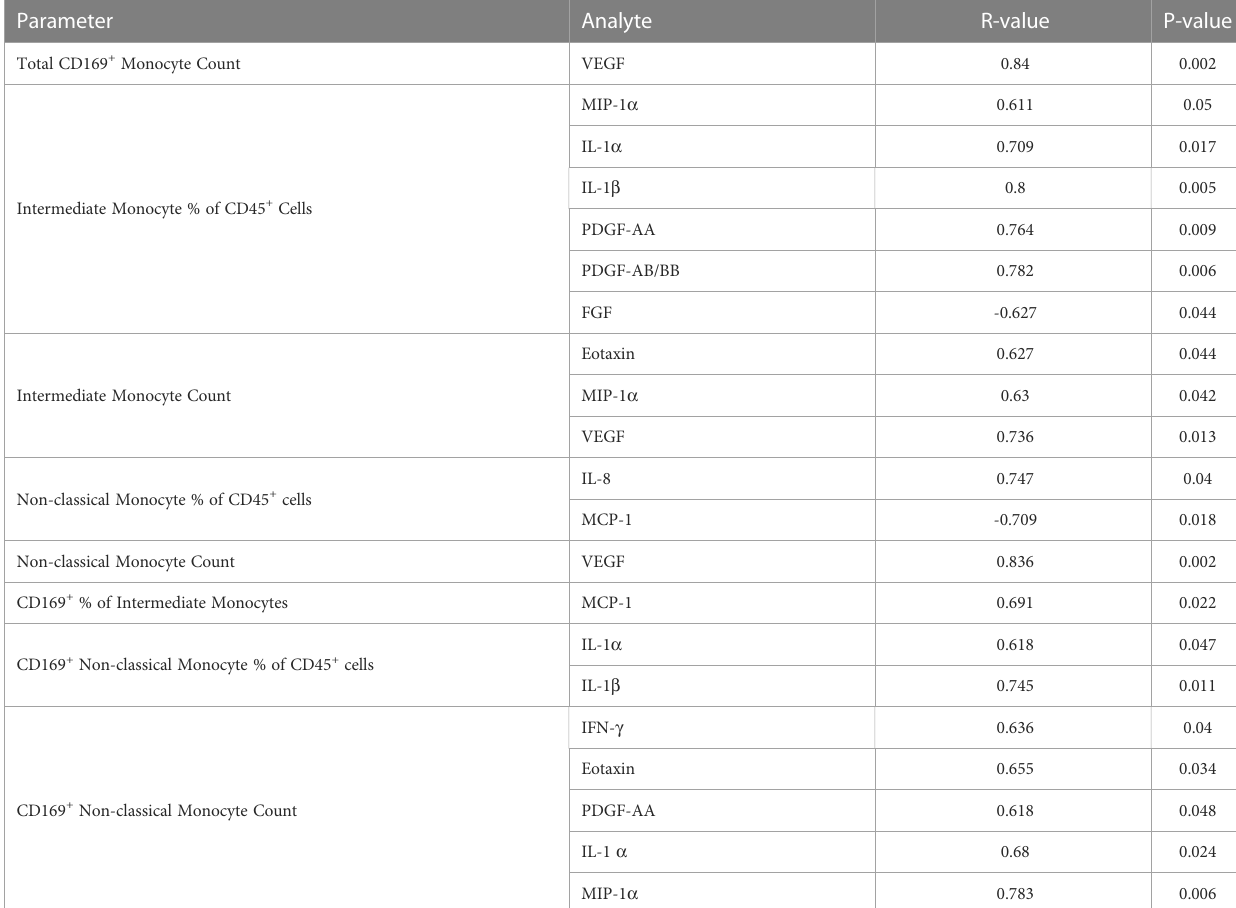
TABLE 2 Spearman correlations of circulating molecules and monocyte populations in PG.